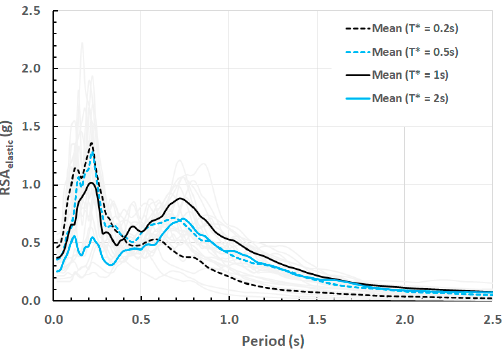
Figure A3. Site-specific mean acceleration response spectra of the four reference periods.